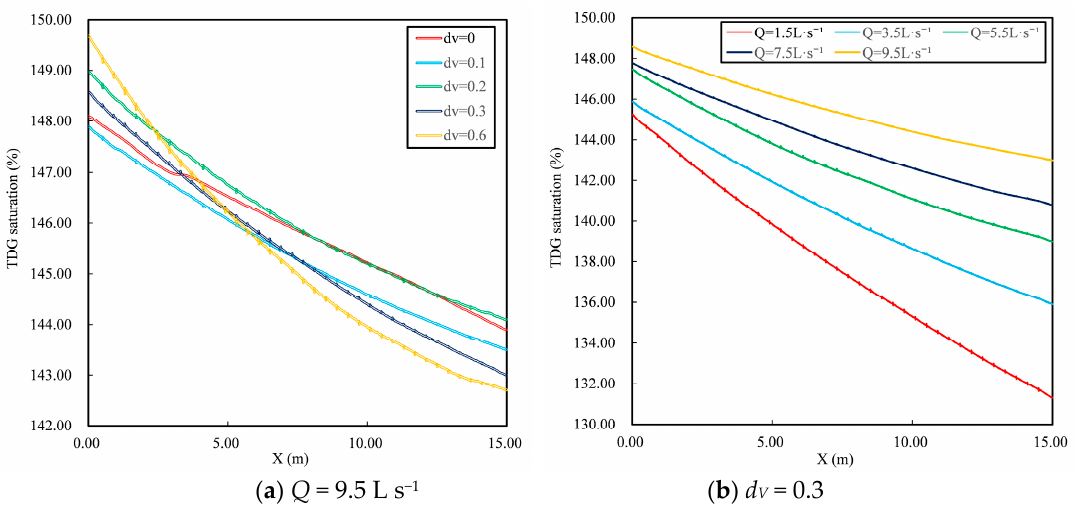
Figure 14. The longitudinal scattergram of supersaturated TDG.